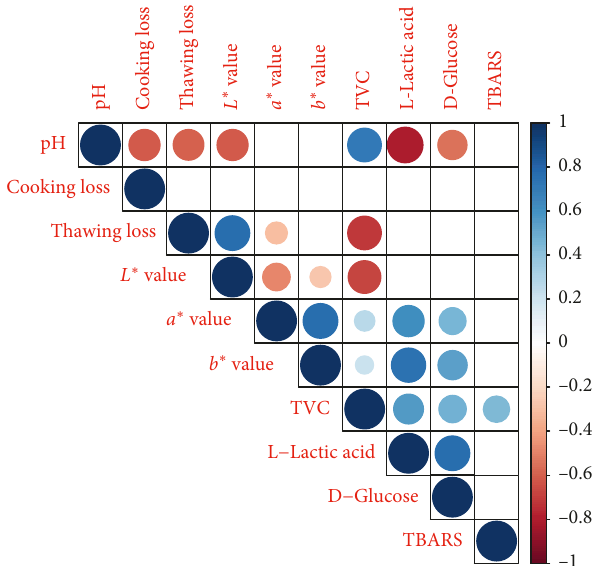
Figure 1: Correlation between physicochemical parameters. Only correlations significant at the 0.05 level are